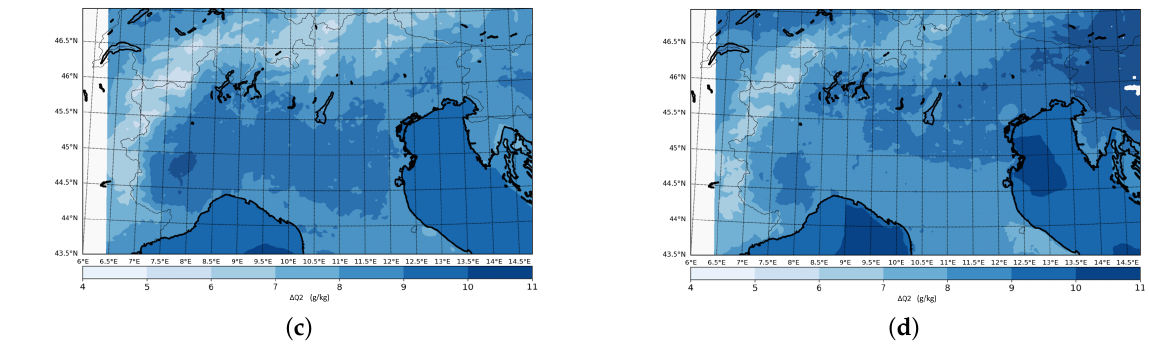
Figure 6. Monthly mean of 2-m height moisture content (Q2) daily average of the differences between the DRIP and CTRL (upper panel), and the absolute values of CTRL (lower panel), for both June (left) and July (right). ( a ) DRIP ∆ Q 2 June 2015. ( b ) DRIP ∆ Q 2 July 2015. ( c ) Control Q 2 June 2015. ( d ) Control Q 2 July